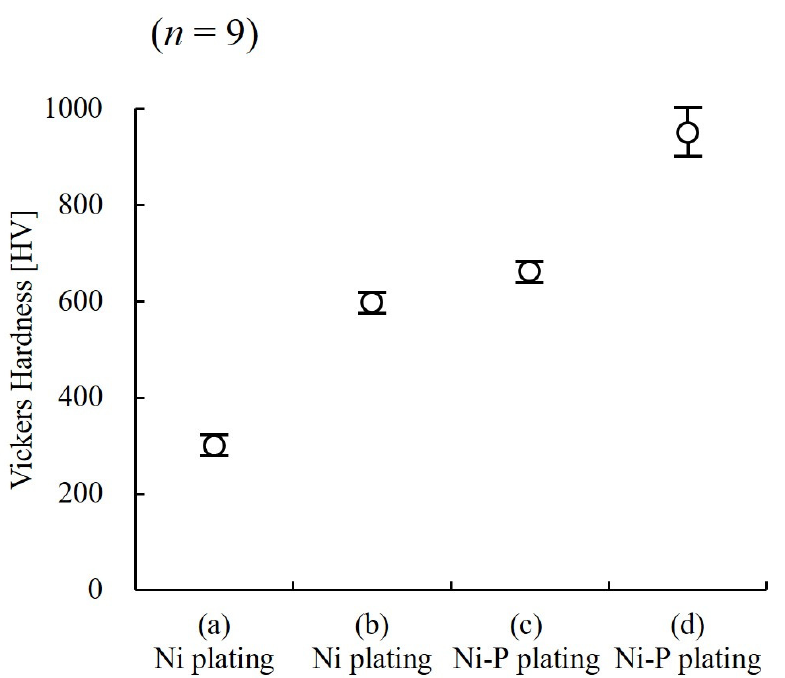
Figure 5. Ni-coating-hardness measurement results. Sample ( a ) is a Ni coating obtained from a basic bath, ( b ) is a coating adjusted by adding 5 mL/L [40] of sulfurous additive to the basic bath, ( c ) is a coating adjusted by adding 20 g/L of phosphorus acid to the basic bath, and ( d ) is a coating of the sample ( c ) heat-treated at 350 °C for 1 h. Sample ( b ) has a hardness of 600 HV and achieves stiffness allowing elastic deformation.